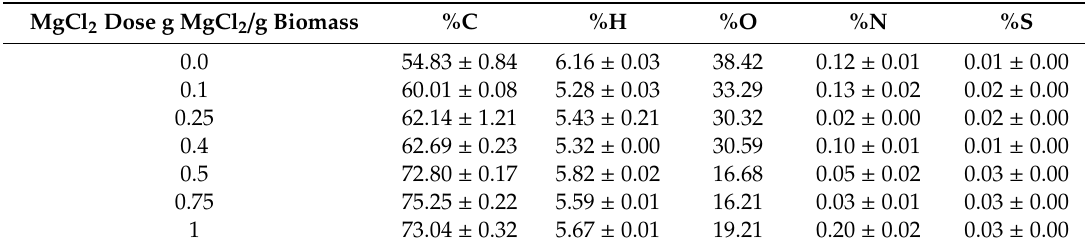
Table 3. Ultimate analysis of the carbonized product.